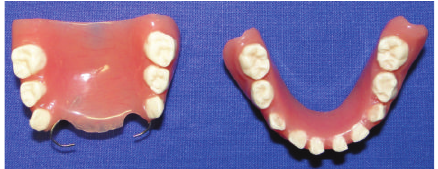
Figure 10: Artificial teeth in acrylic resin.